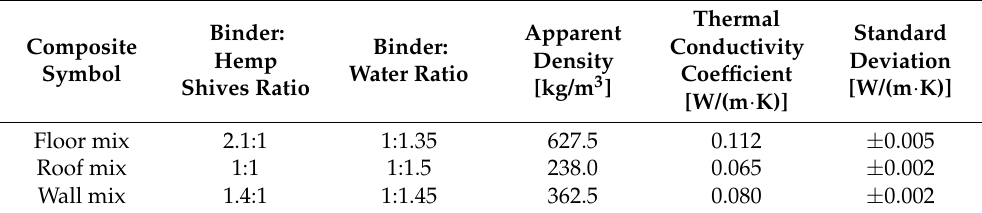
Table 1. Recipes of hemp–lime mixes (weight ratio), apparent density, and thermal conductivity of the tested